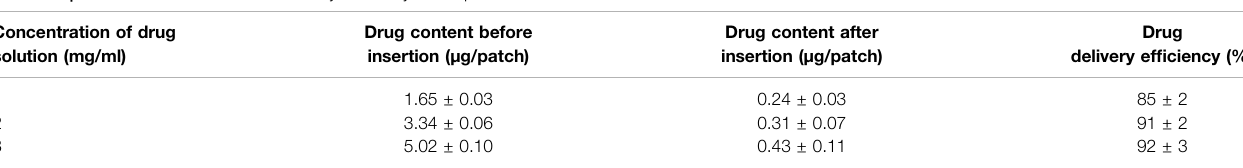
Results are presented as the mean ± S.D. of at least fi ve